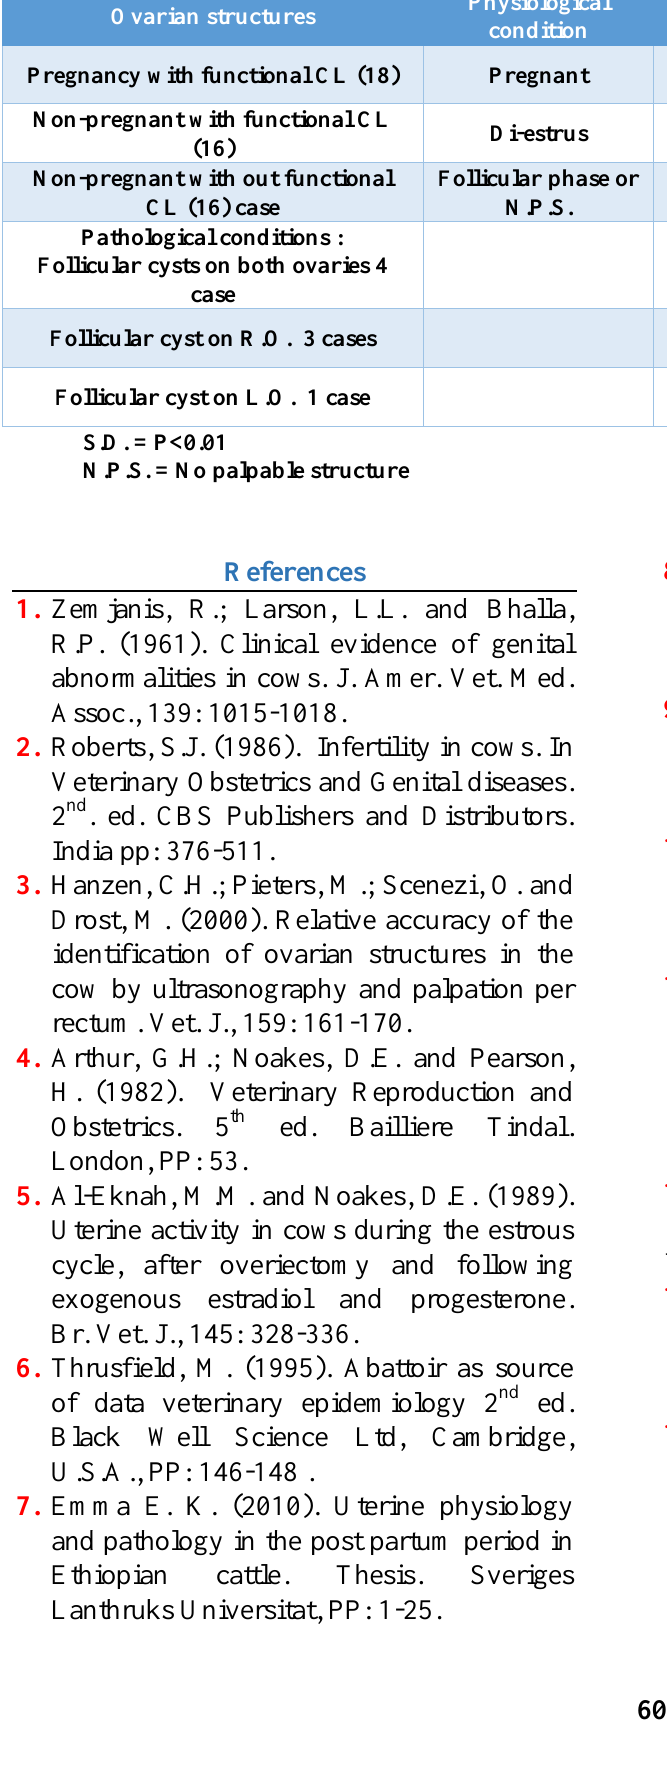
Estrogen Pmol/L